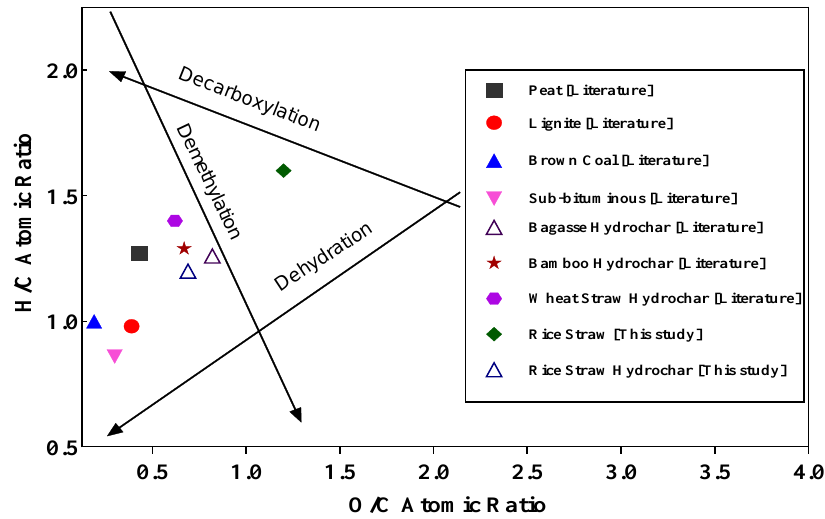
Figure 5. The H/C atomic ratio versus the O/C atomic ratio.